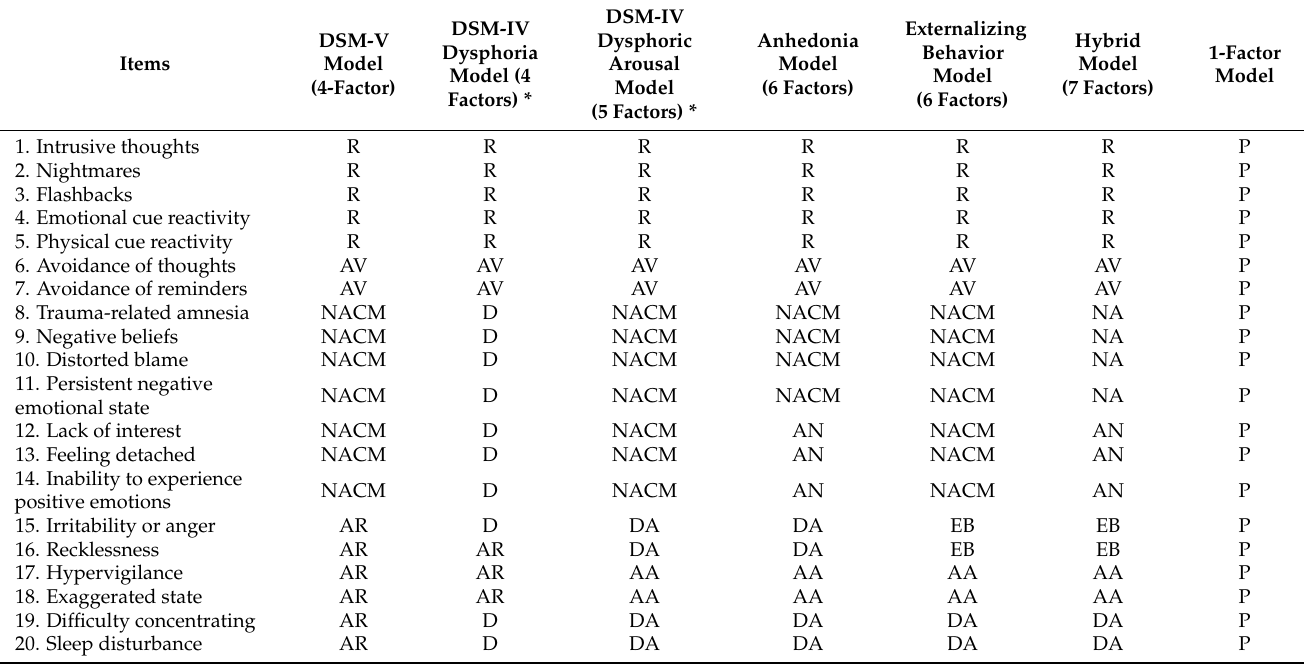
Table 3. Item mapping of the main alternative factorial models proposed for the